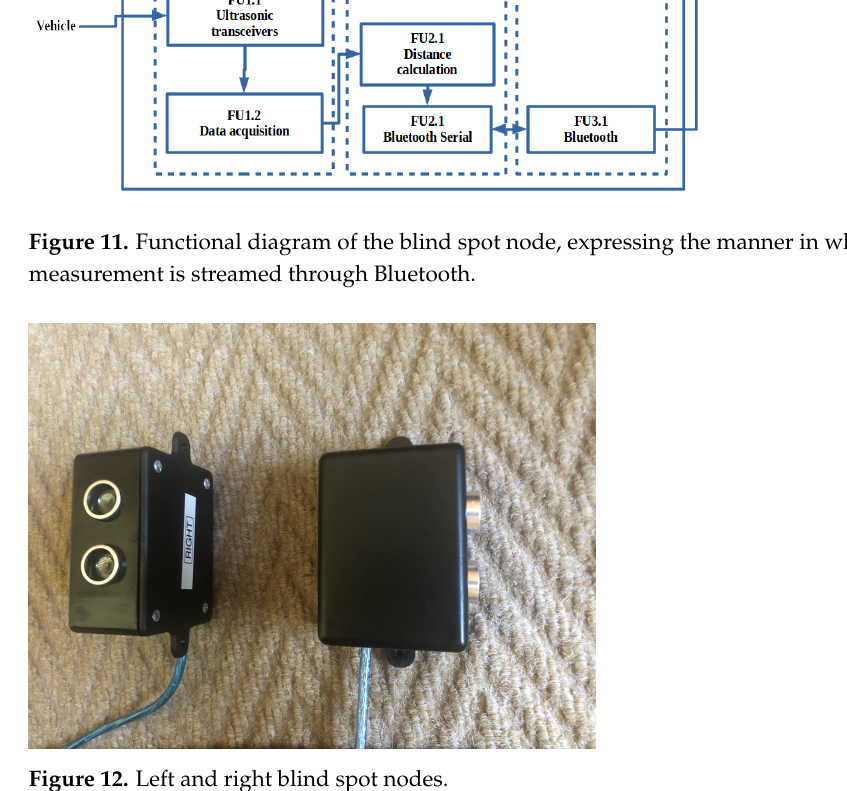
Figure 12. Left and right blind spot